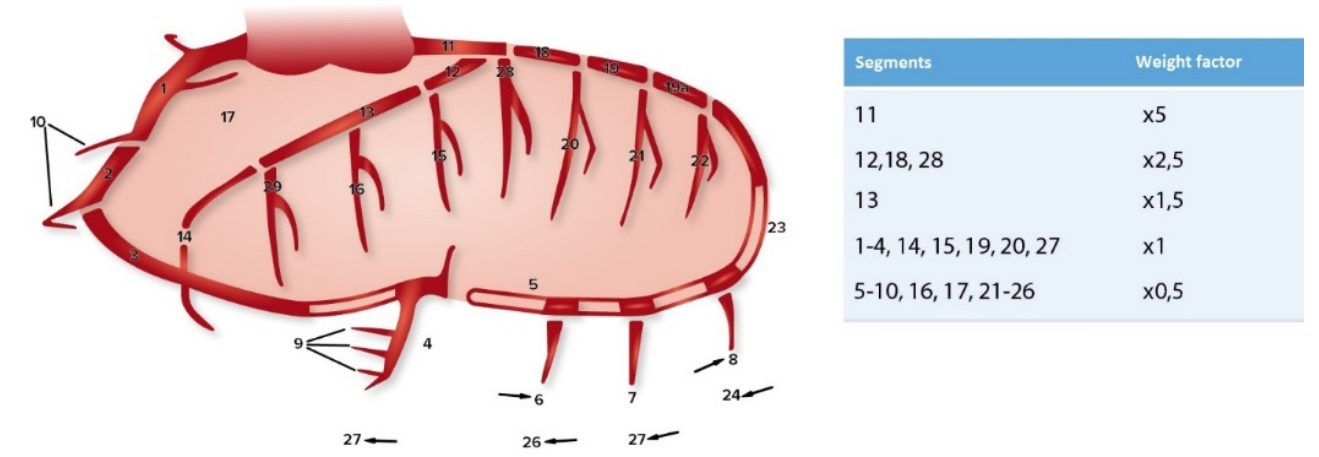
Figure 1. Coronary artery segments (according to CASS) and the corresponding weight factors used for the CAGE score [11,13].